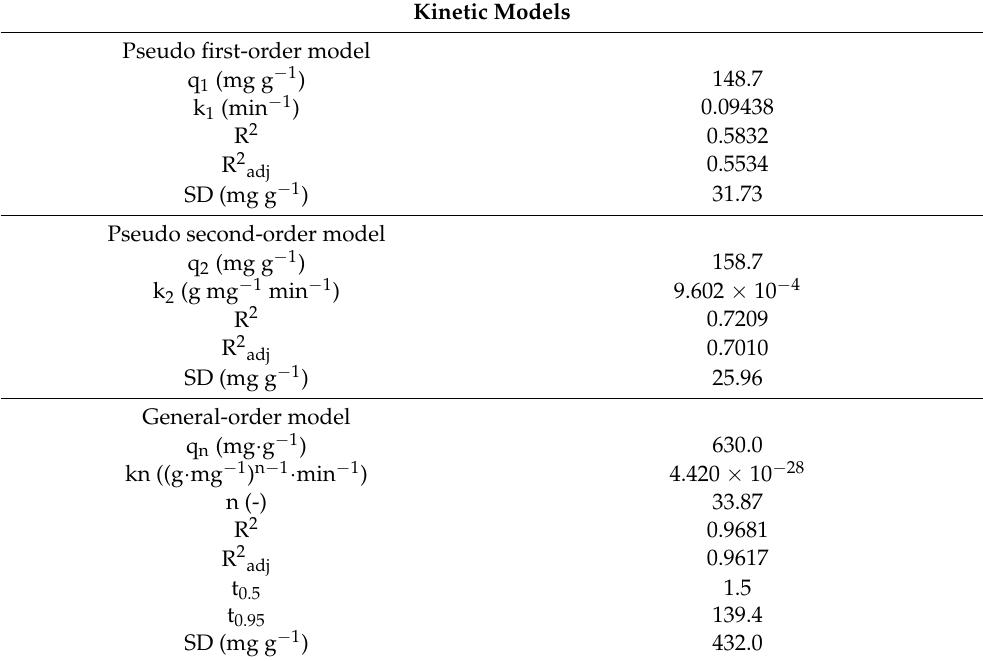
Table 4. Kinetic fitting parameters.